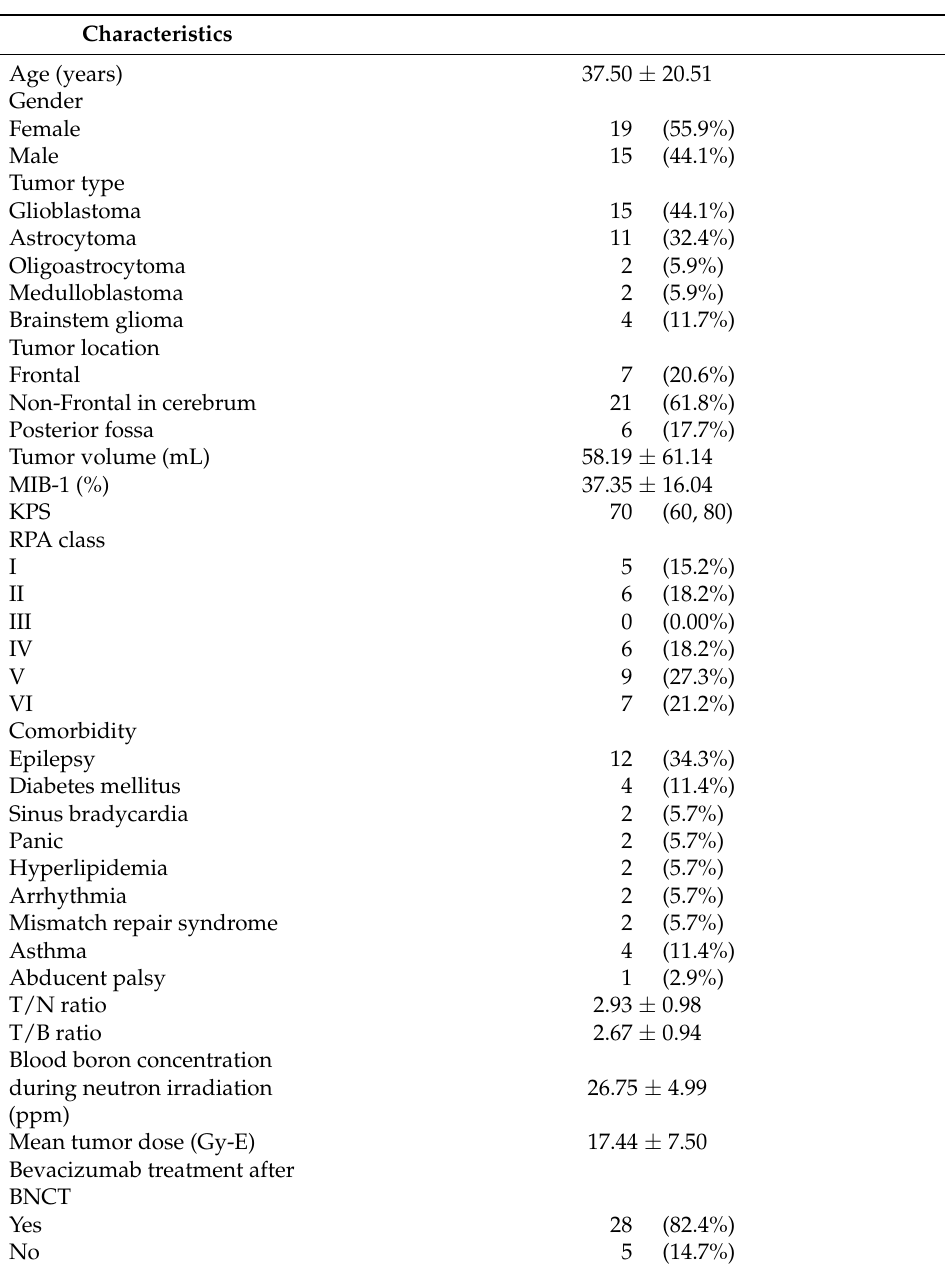
Table 1. Demographics of the patients before and during boron neutron capture therapy (BNCT) treatment (N =